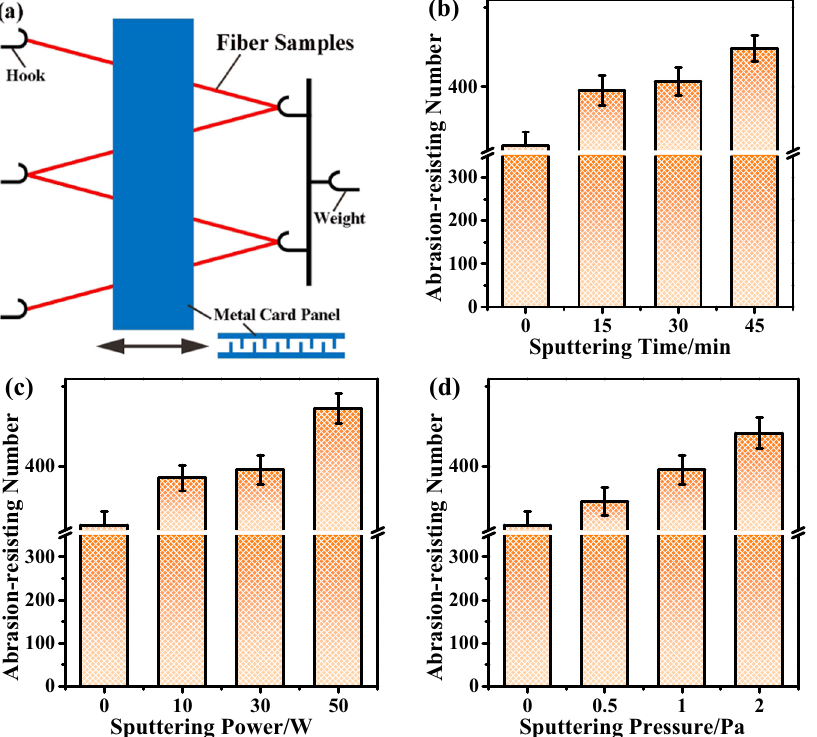
Figure 7: ( a ) Schematic of abrasion resistance test; ( b – d ) e ff ects of technological variables, i.e., sputtering time, power, and pressure, on the abrasion resistance behavior of PP fi